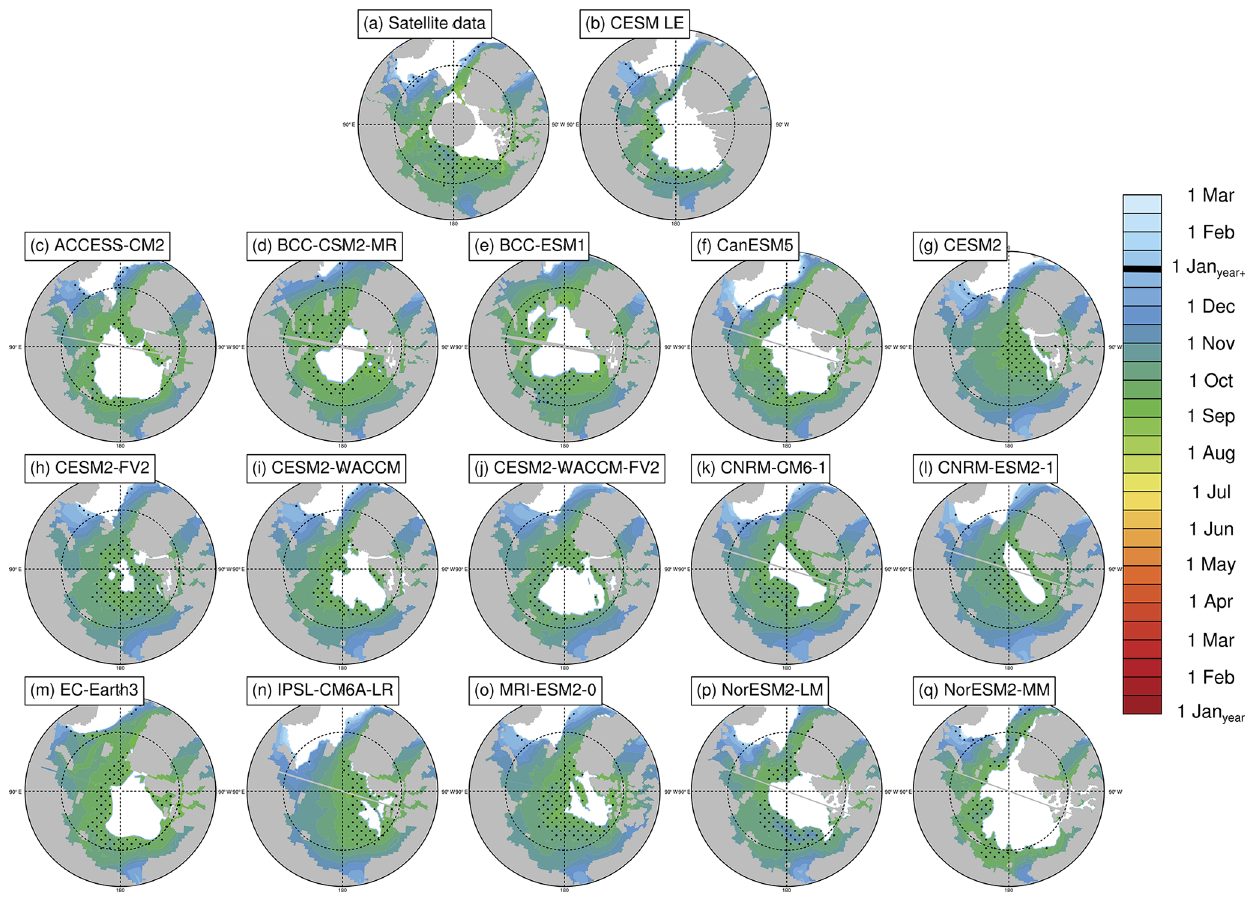
Figure 6. Freeze-up dates (15% ice concentration threshold) averaged over the period 1979–2014 at each grid cell using satellite data (a) , the first ensemble member of the CESM LE (b) , and the first ensemble member of each CMIP6 model (c–q) . Stippling indicates where freeze-up dates exist in less than 20% of years in the time range. Models on tripolar grids produce plot gaps filled by gray